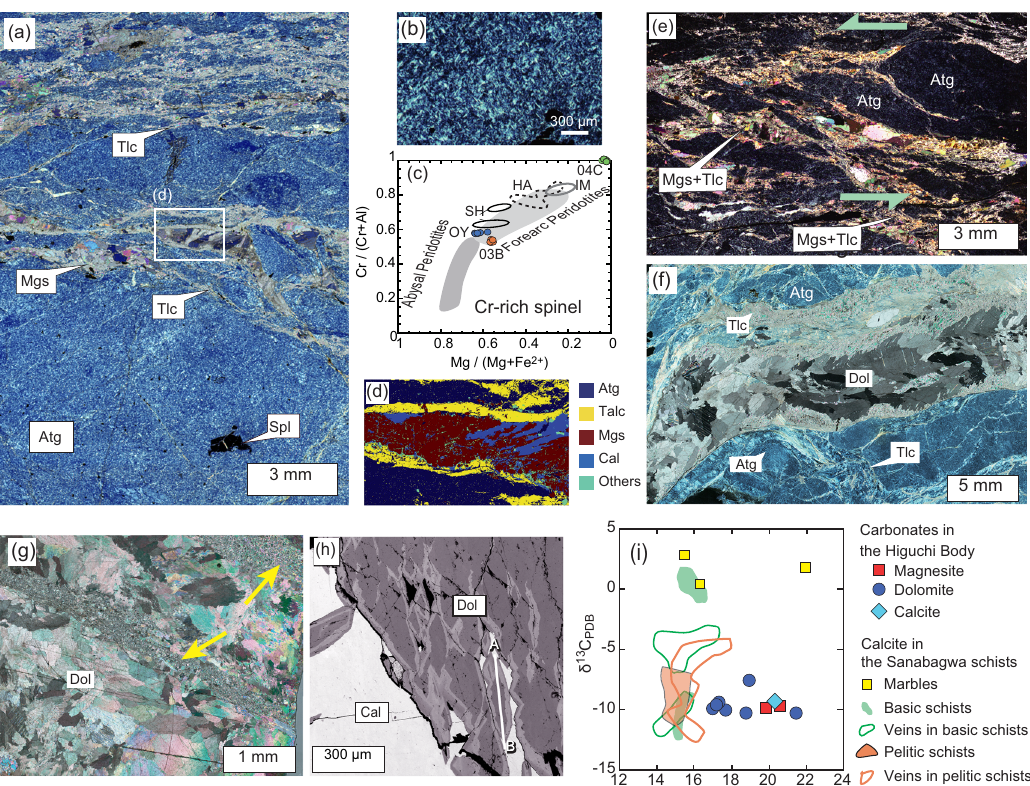
Fig. 2 Microstructure and chemistry of minerals in the Higuchi serpentinite body. a Photomicrograph (crossed polarized light) showing massive antigorite and magnesite patches associated with talc vein networks. b Detail of antigorite showing random grain orientations. c X Cr ( = Cr/(Cr + Al)) vs. X = Mg/Mg + Fe 2 + ) for Cr-rich spinel in the serpentinite body (OY, 04C) and actinolite – chlorite schist (03B), compared with data from abyssal Mg ( peridotites and Mariana forearc peridotites 46 . Serpentinized peridotites in the Sanbagawa belt, central Shikoku 43,47 (references therein): SH Shiraga body, HA Higashi Akaishi body, IM Imono body. d Mineral map of magnesite patches rimed by talc. Location of map shown in a . e Asymmetric antigorite blocks in fi lled by magnesite + talc produced by brittle shear deformation. f Dolomite veins with talc rims from the outcrop in Fig. 1b. g Dynamically recrystallized dolomite grains within a localized shear zone from a coarse-grained dolomite vein shown in Fig. 1c. h BSE image of a thick dolomite – calcite vein. Euhedral dolomite crystals with bright rims occur along the margin of the vein, and anhedral calcite occurs in the center of the vein. The compositional pro fi le of dolomite along line A-B is shown in Supplementary Fig. 3. i Isotopic compositions ( δ 13 C PDB and δ 18 O SMOW ) of carbonates (magnesite, dolomite, and calcite) in veins from the Higuchi serpentinite, compared with marbles from central Shikoku and the compositions of calcite in basic schists and pelitic schists, and associated veins in the Nagatoro area 50